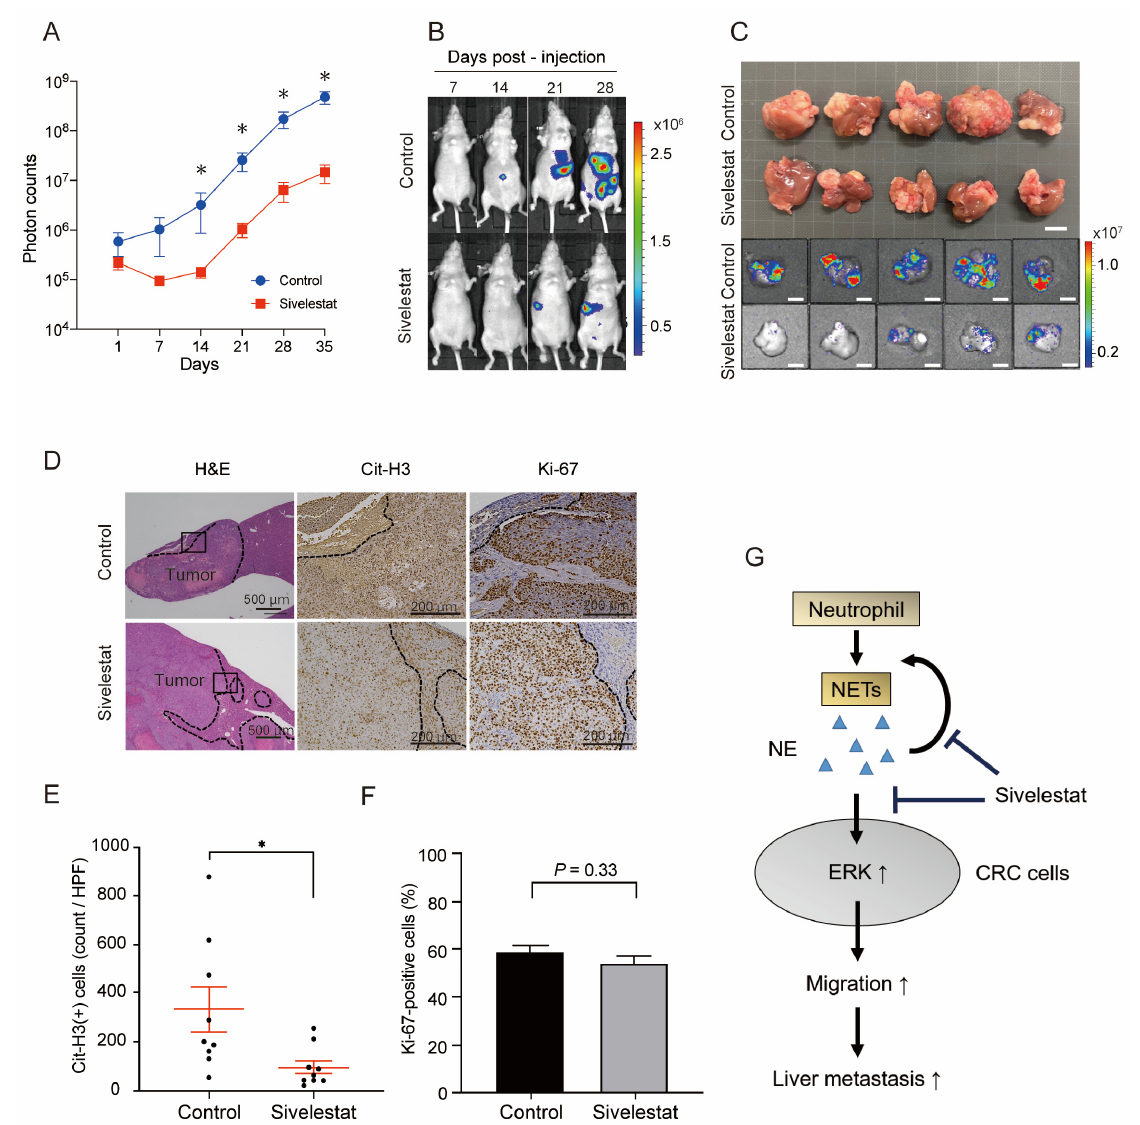
Figure 5. The suppression of NET formation by NE inhibitors decreased liver metastases. ( A ) Quantification of HCT116-Luc liver metastatic lesions (photon counts) in KSN/slc nude mice treated with sivelestat (10 mg/kg) or vehicle control. Mean: bars ± SEM. n = 9 mice in each group. * p < 0.05 with Mann–Whitney U test. ( B ). Representative in vivo bioluminescence images of HCT116- Luc liver metastases in KSN/slc nude mice treated with sivelestat (10 mg/kg) or vehicle control. ( C ) Representative macroscopic and bioluminescence images of the HCT116-Luc liver metastatic tumors dissected from KSN/slc nude mice treated with sivelestat (10 mg/kg) or vehicle control on day 35. Scale bars, 10 mm. ( D ). IHC staining for H&E, Cit-H3 and Ki-67 in experimental liver metastasis. Representative images are shown. Scale bars, 500 µ m for H&E, 200 µ m for Cit-H3 and Ki-67 staining. E and F. Quantification of Cit-H3-positive cells ( E ) and percentage of Ki-67-positive cells ( F ) in the IHC staining of xenograft tumors. Mean: bars ± SEM. n = 9 tumors in each group. * p < 0.05 with Student’s t -test. ( G ) Schematic representation of the possible mechanism by which NETs promote the liver metastasis of CRC cells. NE released during NETosis increases ERK activity, which accelerates the migration of CRC cells. Inhibition of NE suppresses the NETosis and the migration of CRC cells resulting in decreased liver metastases.